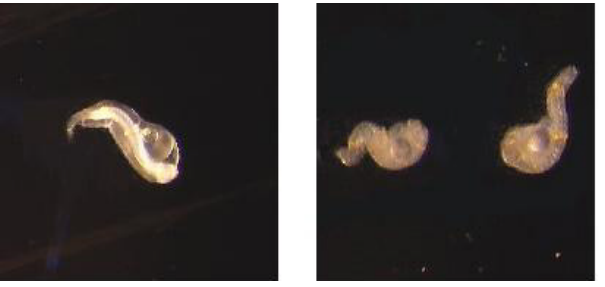
FIGURE 3. Seabream larvae exposed to lethal LAS concentrations. (a) Larva exposed to 0.25 mg l -1 LAS C 14 ; (b) larva exposed to to 0.50 mg l -1 LAS C 14 .